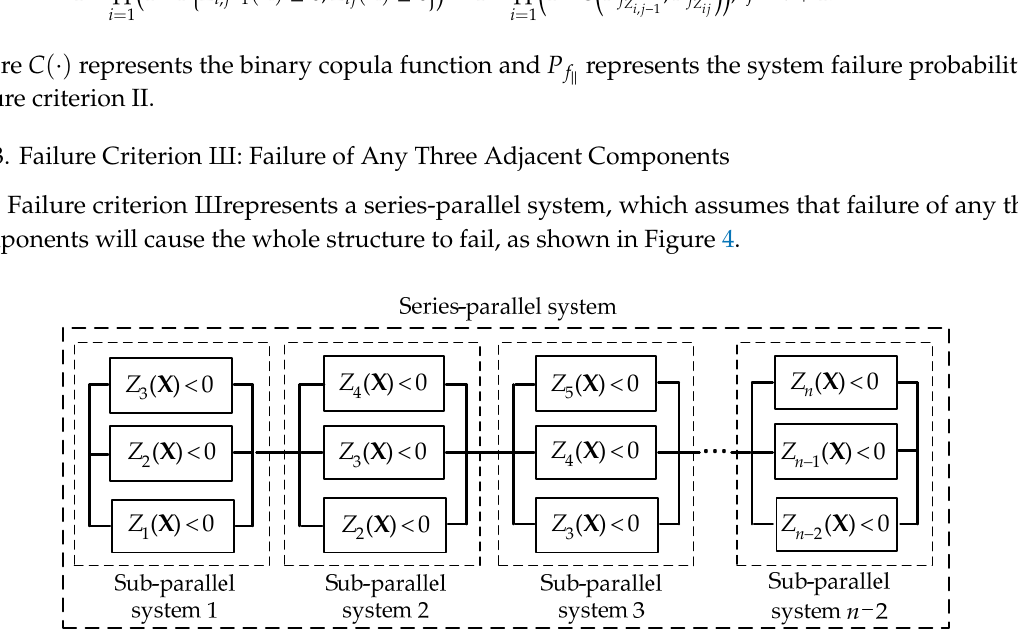
Figure 4. Series ‐ parallel system composed of multiple sub ‐ parallel systems (sub ‐ parallel system with three components).